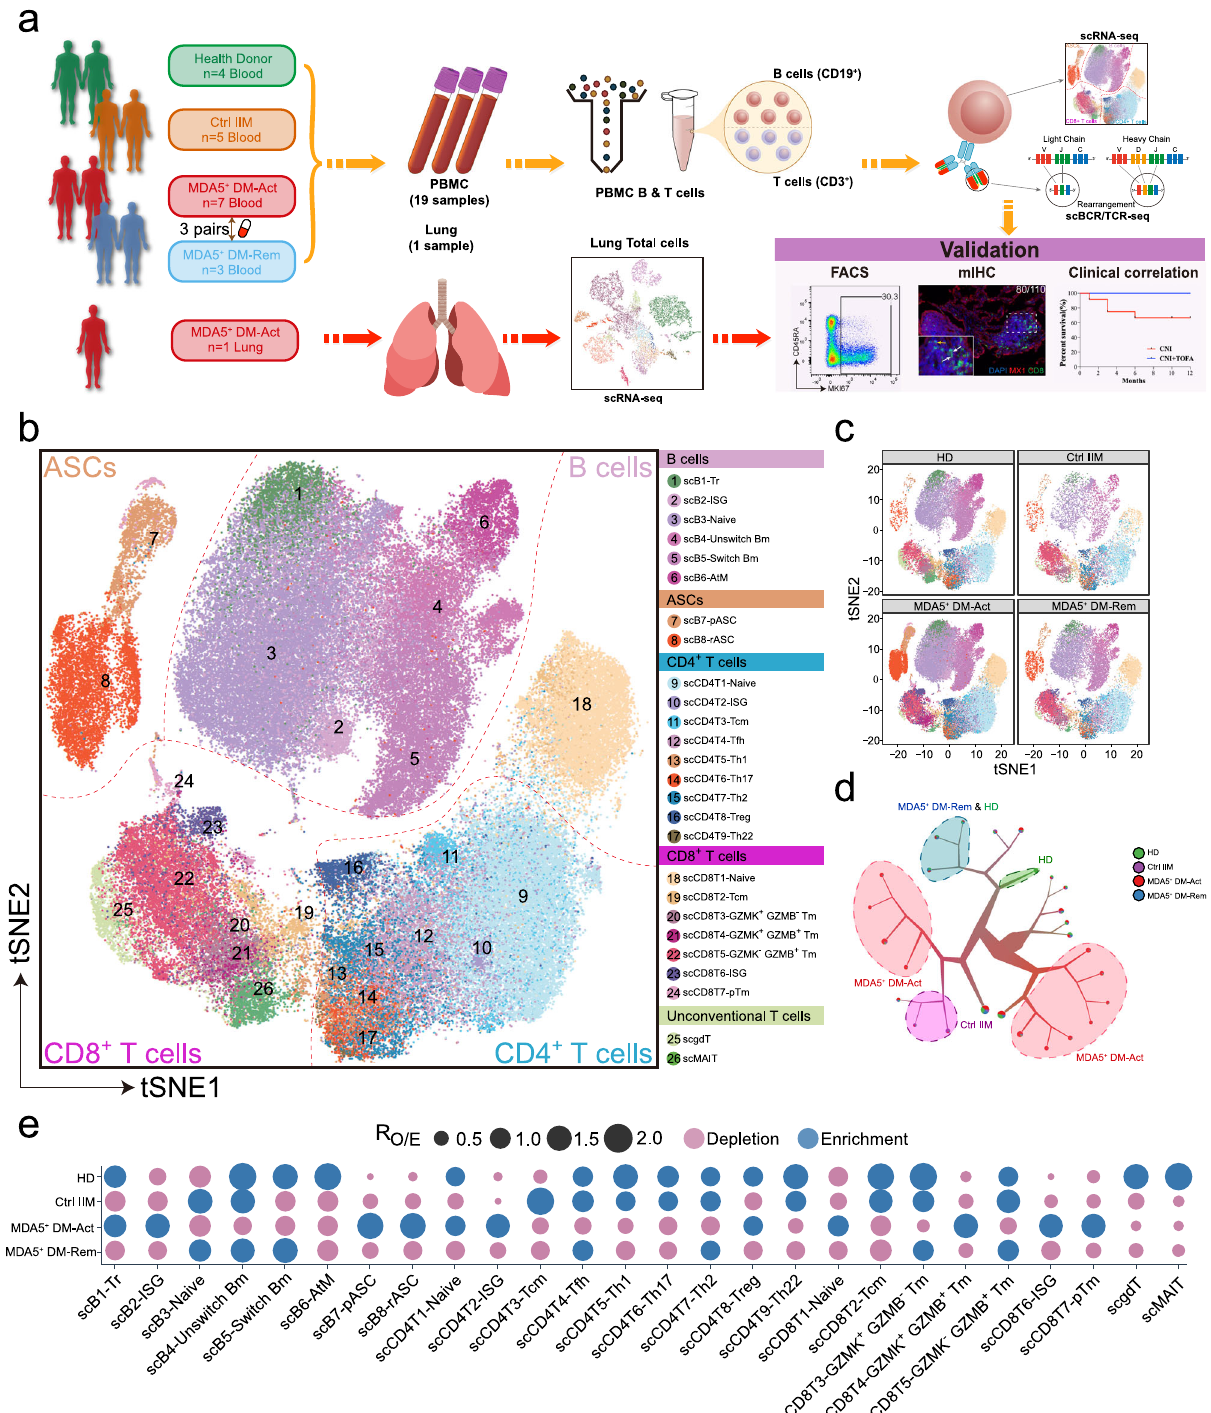
Fig.1|Single-cellatlasofperipheralBandTcellsfromMDA5 + DMpatientsand controls. a Flowchart depicting the overall experimental design of this study. Adobe Illustrator 2020 was used to create the image. b t-SNE plot showing the overview of 26 cell clusters in the integrated single-cell transcriptomes of 111,200 peripheralBandTcellsderivedfromMDA5 + DMpatients,IIMdiseasecontrols,and HDs (Supplementary Table 1). Clusters are named according to the indicated immune cell subsets using the speci fi c gene expression patterns (Supplementary Table 2) and are color-coded. c t-SNE plots showing the single-cell transcriptomes